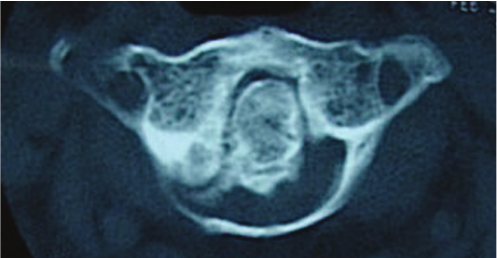
Figure 2: Axial CT scan at the level of the atlas demonstrating severe narrowing of the spinal canal and ossified transverse atlantal liga-